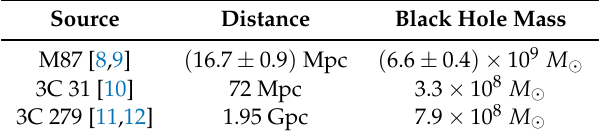
Table 1. Distances to, and central black hole masses of, jet/accretion disk/black hole (JAB) systems.